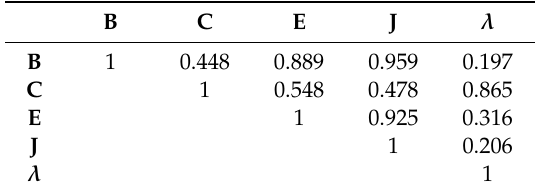
Table 6. Correlations between key